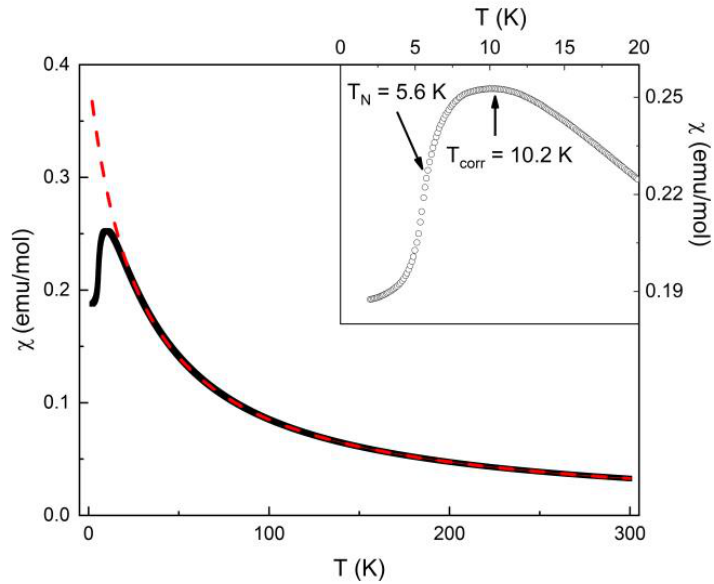
Figure 3. Temperature-dependent magnetic susceptibility χ of Ba 2 Mn 3 (SeO 3 ) 6 taken at µ 0 H = 0.1 T in the field-cooled regime. The dashed line represents the extrapolation of the Curie–Weiss fit. The inset shows a zoomed-in view of the low temperature region of the χ ( T ) curve. On lowering the temperature, the χ (T) curve passes through a broad maximum at T corr = 10.2 K and shows a kink at T N = 5.6 K, which is more pronounced in the Fisher’s specific heat d( χ T)/dT (not shown). This broad maximum is typically found for a quasi-one- dimensional (1D) antiferromagnetic chain system; hence, suggesting that Ba 2 Mn 3 (SeO 3 ) 6